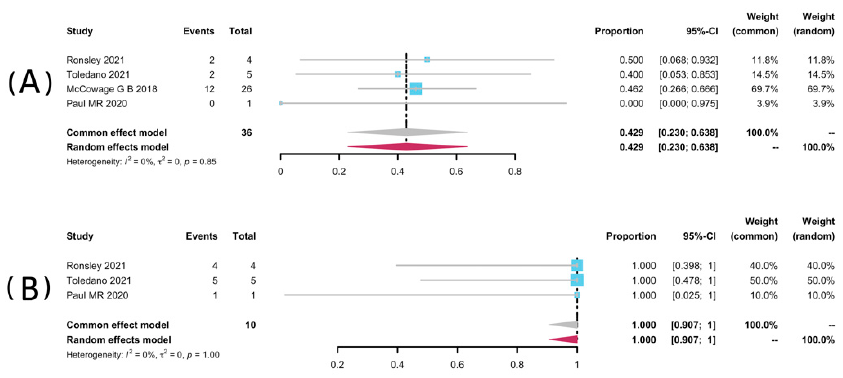
Figure 3. Forest plots for the objective response rate ( A ), and the disease control rate ( B ) in pNFs patients receiving